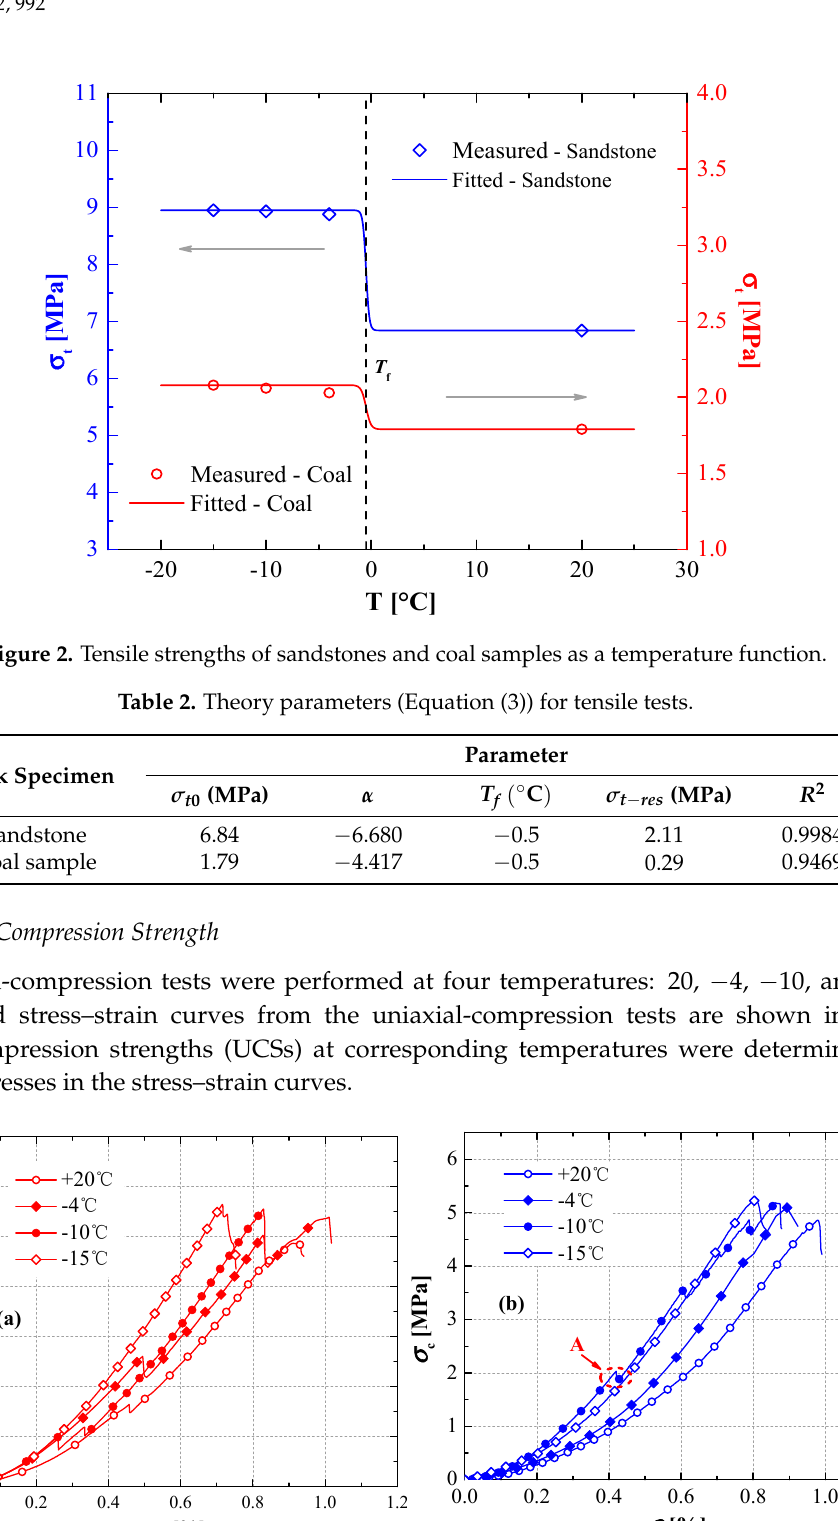
Figure 3. Stress–strain curves from uniaxial-compression tests: ( a ) sandstone; ( b ) coal samples.